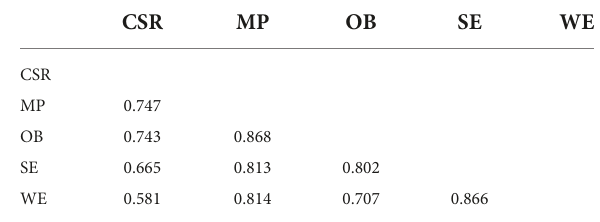
TABLE 2 Discriminant